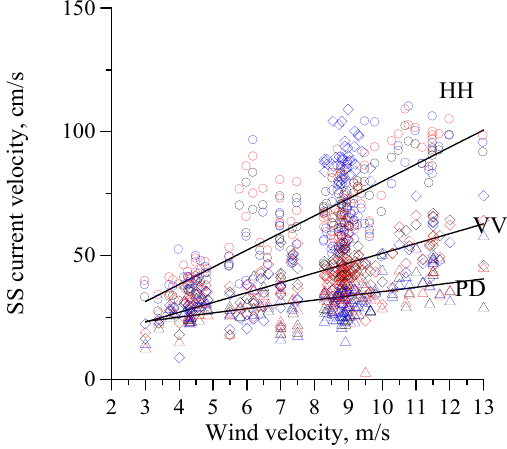
Figure 11. The velocities of VV/HH/Bragg scatterers and subsurface current velocity determined from VV/HH/PD vs. wind velocity. Black symbols—S-band, red—C-band, blue—X-band, circles—HH, diamonds—VV, triangle—PD.